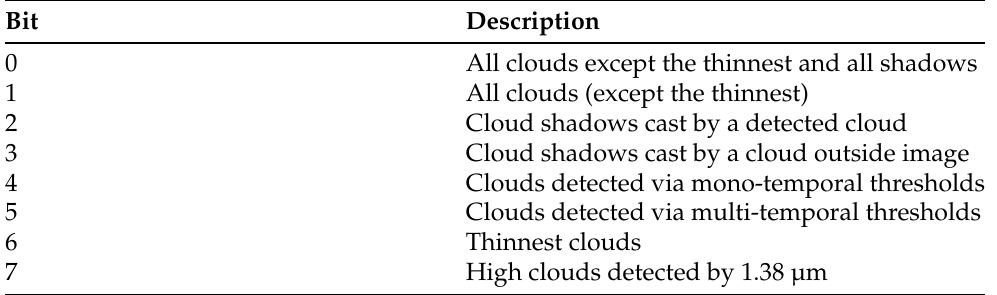
Table 2. Bit interpretation of the MACCS-ATCOR Joint Algorithm’s (MAJA) cloud mask. Source